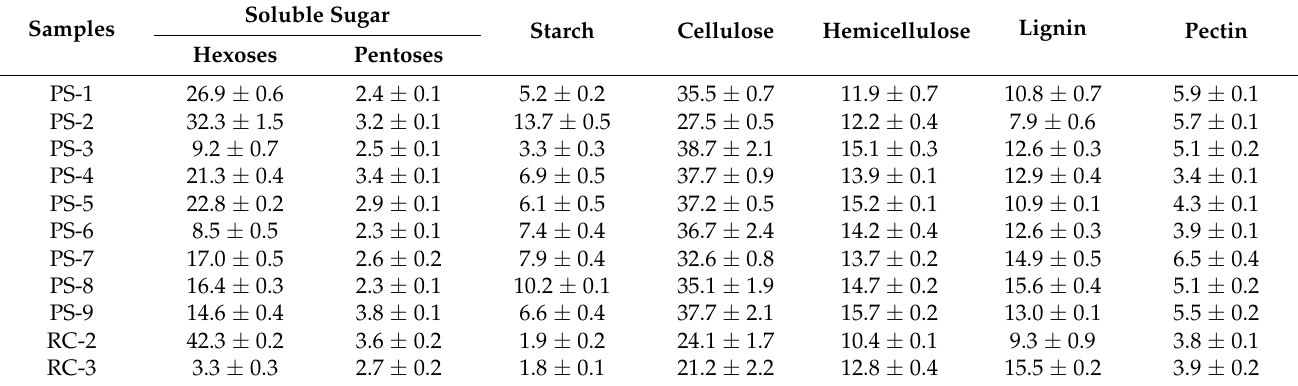
Table 1. Edible soluble sugars and starch and lignocellulose compositions (% dry matter) among 11 total banana samples.